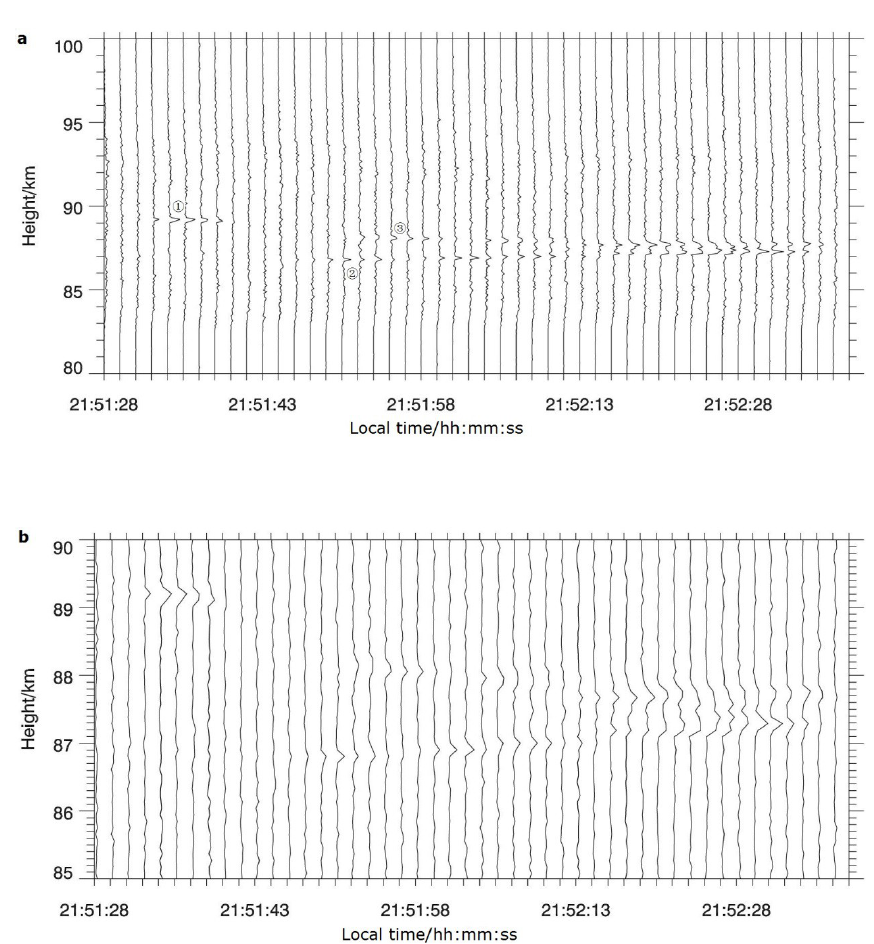
Fig. 11. (a) The evolution of the Na s layer in Fig. 10 observed at the time resolution of 1.5s to show that each branch constituting the Na s layer, marked with (1), (2) and (3), corresponds to a meteor trail/multiple trails. (b) The same as (a) but on an expanded height scale, to show the similarity between this Na s layer and the conventionally observed Na s